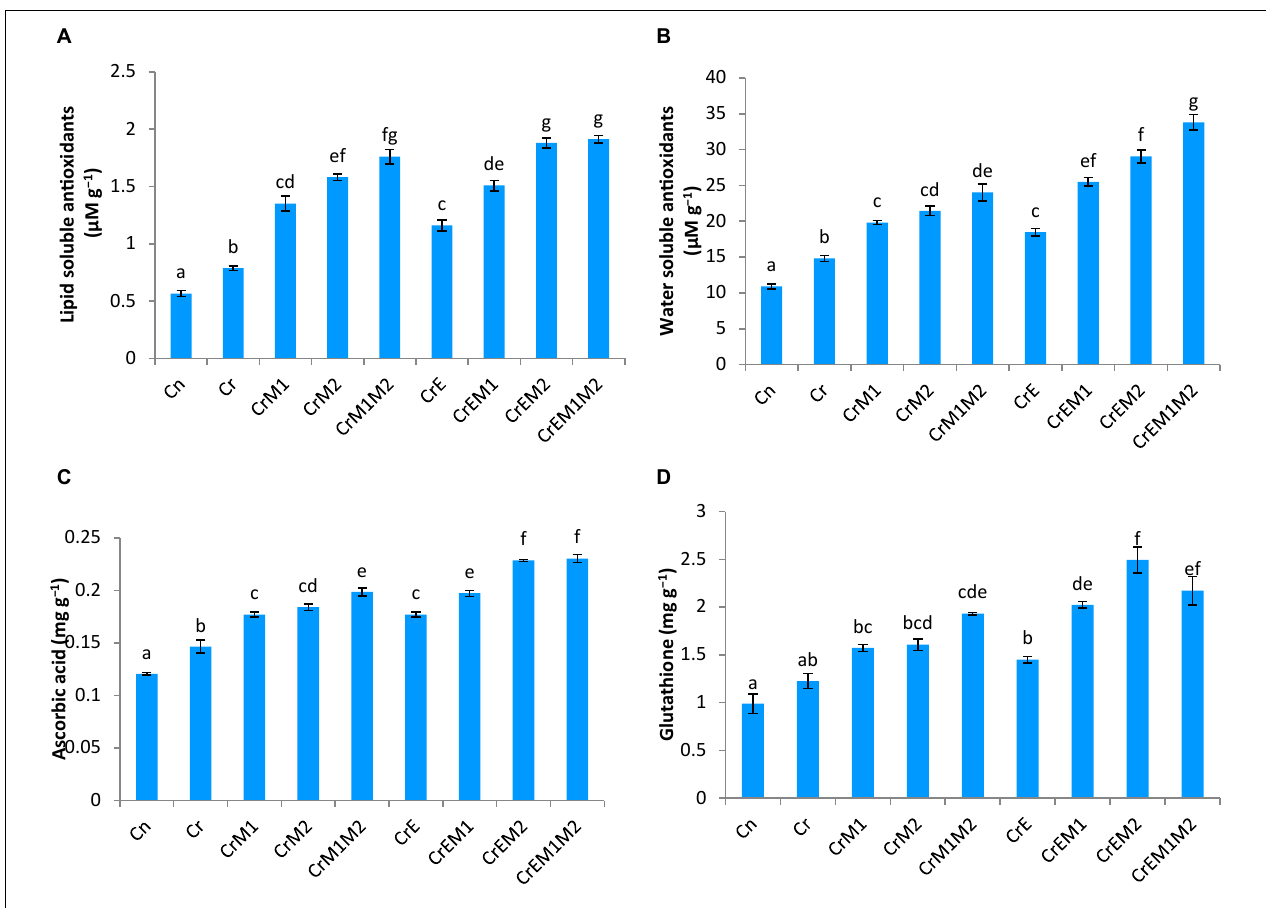
FIGURE 5 | Effect of PGPR [ Pseudomonas aeruginosa (M1) & Burkholderia gladioli (M2)] and earthworms [ Eisenia fetida (E)] on (A) lipid soluble antioxidants, (B) watersoluble antioxidants, (C) ascorbic acid, and (D) glutathione content in 10-day-old B. juncea seedlings, under chromium (Cr) toxicity. Data are presented as means of 3 independent replicates ± S.E (standard error). Different letters on the bar graphs indicate that mean values of the treatments are significantly different at p ≤ 0.05 (Tukey’s test).